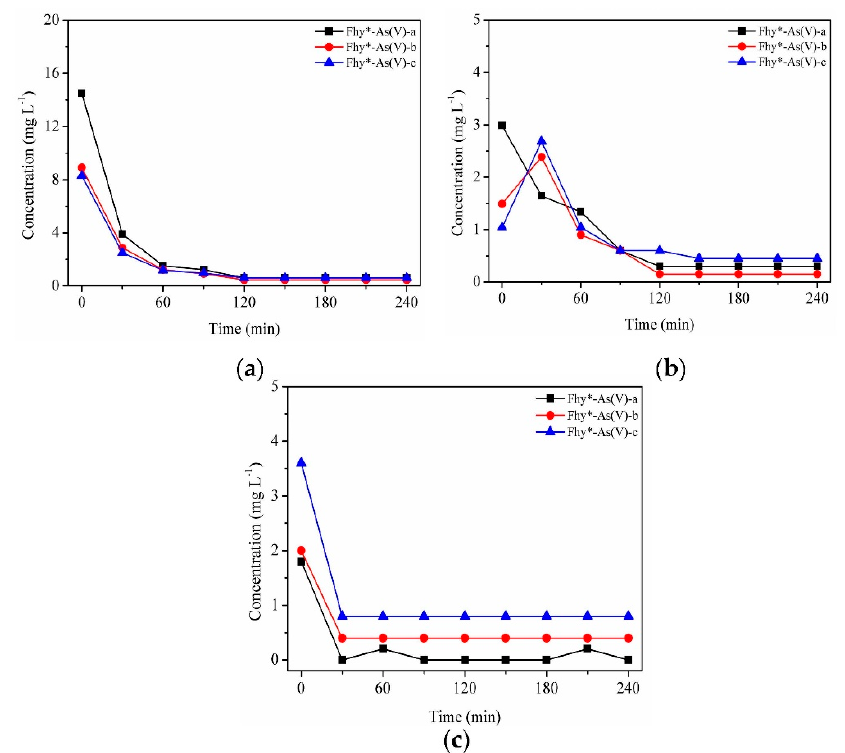
Figure 8. Dissolution kinetics under UV illumination with suspensions of 0.1 g L − 1 Fhy*-As(V) at pH 3.0 with 1.0 mM oxalic acid. Dissolved TFe ( a ), dissolved Fe(II) ( b ), and As(V) ( c ) were measured.